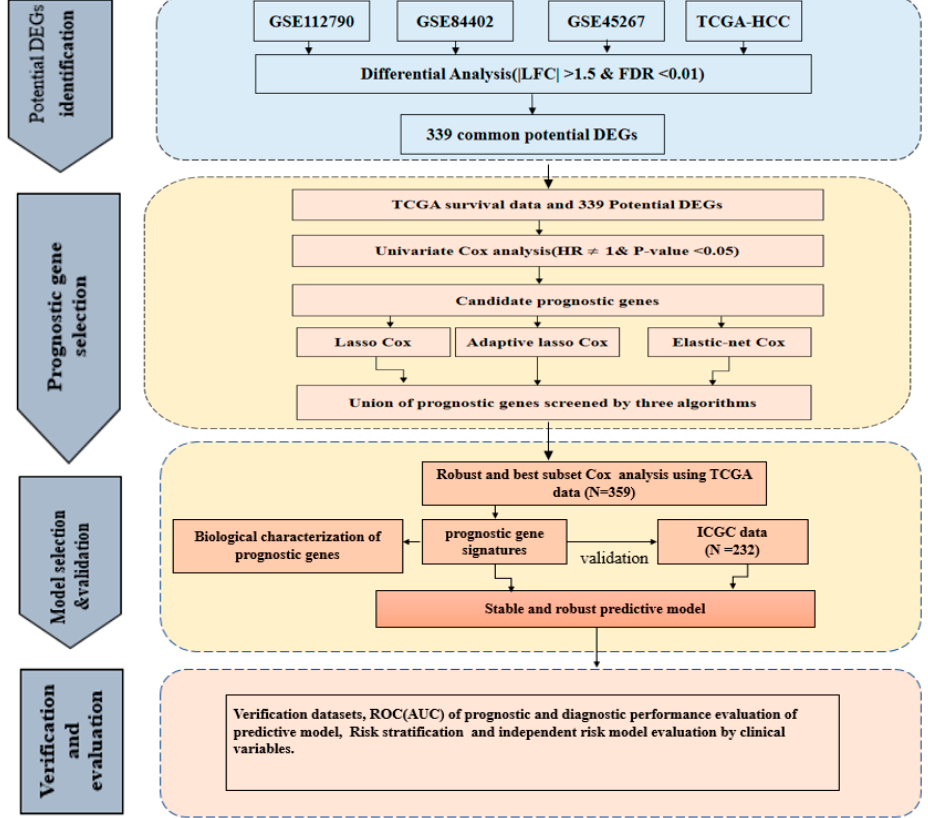
Figure 1. The workflow of our study.